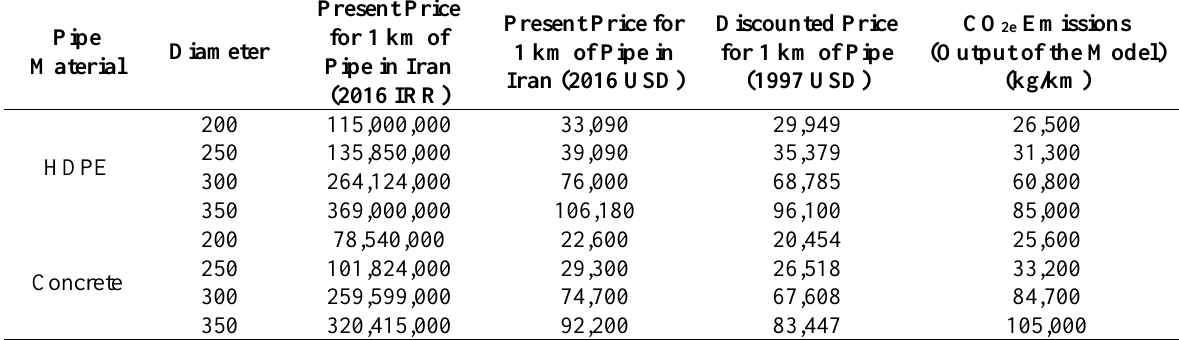
Table 1. Present and converted prices and the model